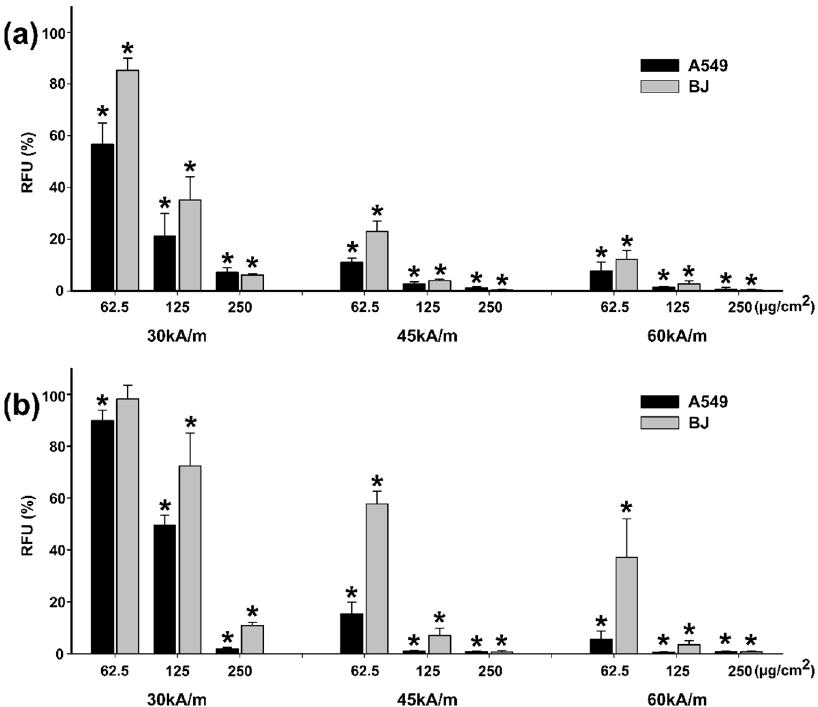
Figure 10. Cytotoxic effects of internalized ZnF01 on A549 and BJ cell lines were evaluated after a 30 min exposure to three different values of H (30, 45, 60 kA/m). Cellular viability was evaluated using Alamar Blue ( a ) and Neutral Red ( b ) assays. Values were expressed as relative values to AMF negative control (100%), as mean ± SD of three biological replicates. Asterisks (*) indicate a significant difference compared to the negative control (ANOVA + Dunn’s; p < 0.05).